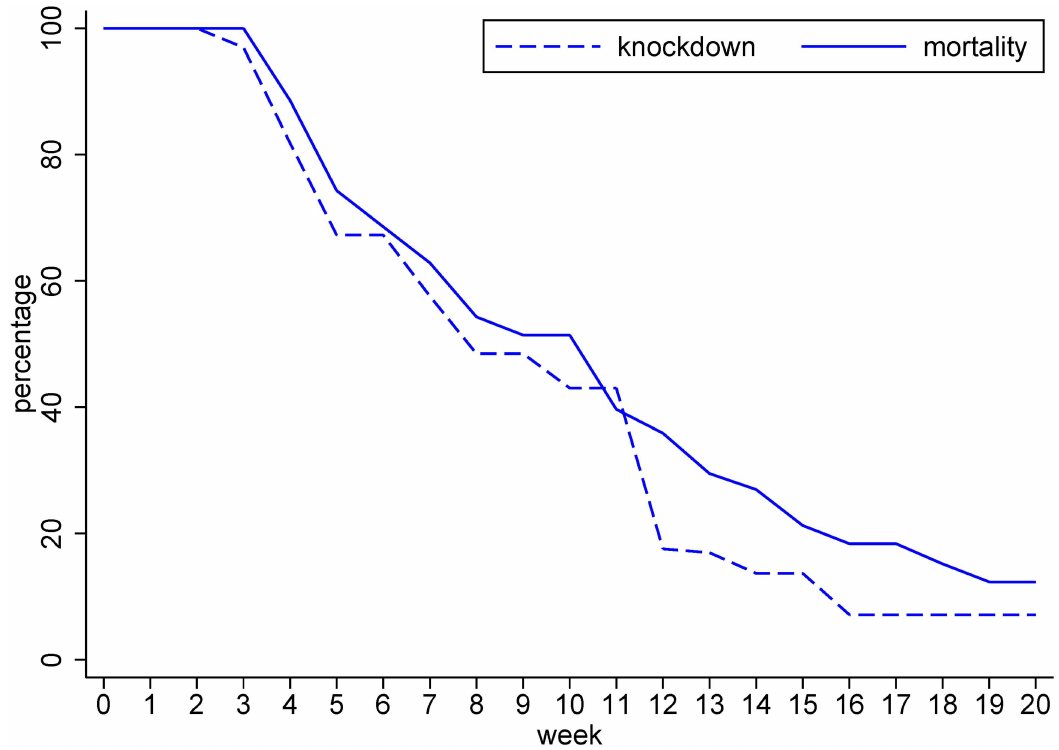
Fig 2. The effect of repeated washing on knock-down (after 1 hour) and mortality (after 24 hours) of Aedes aegypti after being exposed to permethrin-impregnated school uniforms.